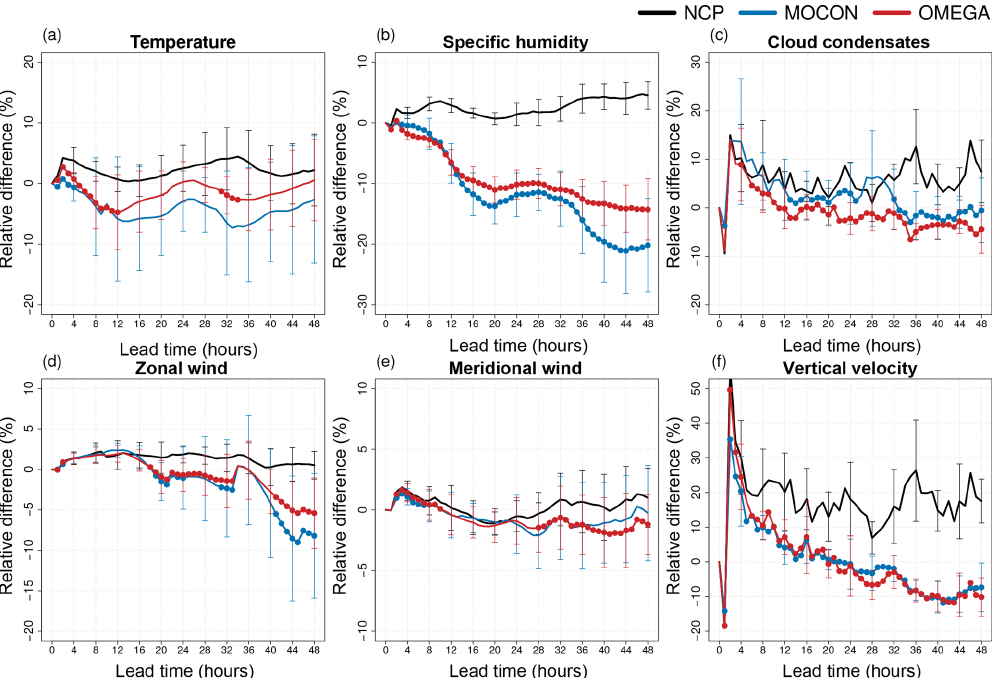
Figure 10. Relative RMSE difference (in percentage with respect to the CP configuration) of the NCP (black) control forecast (deterministic) and the MOCON (blue) and OMEGA (red) ensemble mean for temperature (a) , specific humidity (b) , cloud condensates (c) , zonal (d) and meridional (e) wind, and vertical velocity (f) at 250hPa. Both ensemble forecasts are performed without perturbations in ICs and LBCs. Error bars show the 95% confidence interval. Lead times where the ensemble mean RMSE is significantly lower than the NCP control RMSE at the 95% confidence level are indicated with a filled circle.